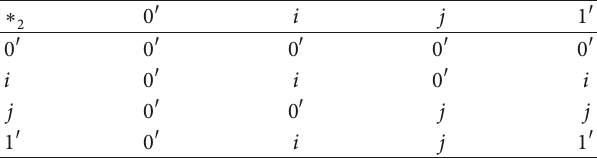
Figure 1: Illustration of 𝑄 𝑡 .